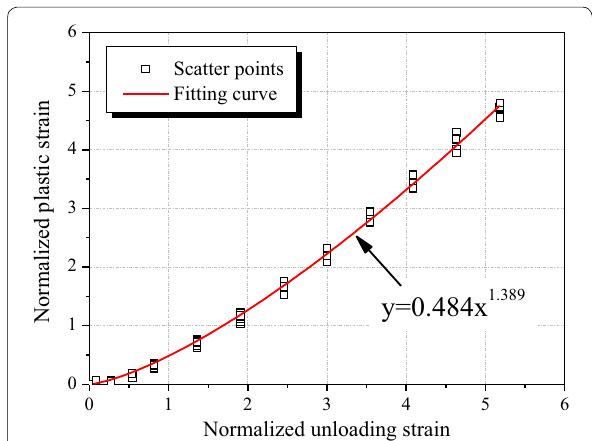
Fig. 8 Relation between plastic strain and envelope unloading strain.